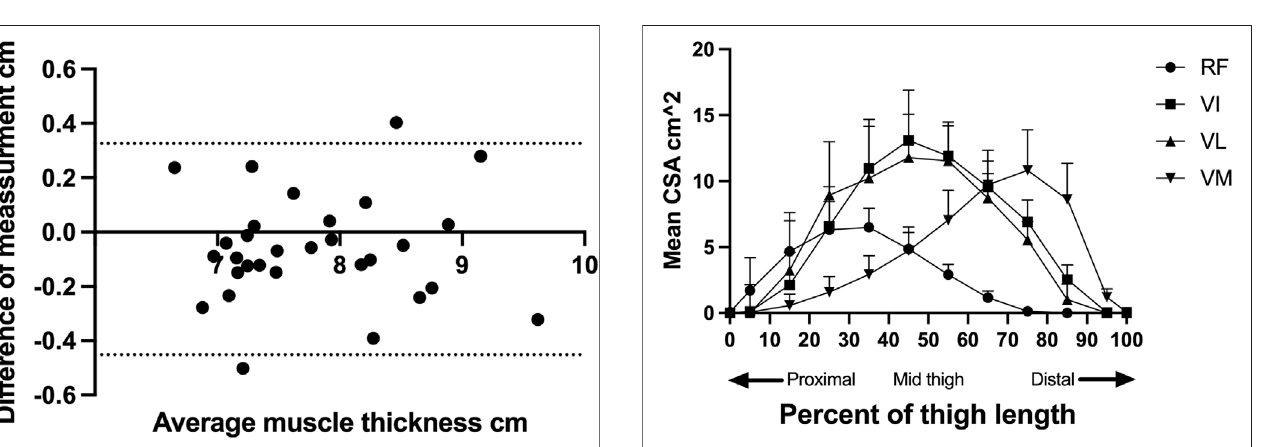
FIGURE 5 | The distribution of mean muscle area of each group (RF, VI, VL, VM) along the length of the thigh, standardized for length. The standard deviationisdepictedbytheerrorbars.The fi rstpercentile isthemostproximal slicewhereRFwasstillidenti fi able,andtheonehundredpercentileisthe most distal slice where m. Vastus Medialis is still identi fi able. RF = m. rectus femoris, VL = m. vastus lateralis, VI = m. vastus intermedius, VM = m. vastus medialis and CSA= Cross-sectional area.